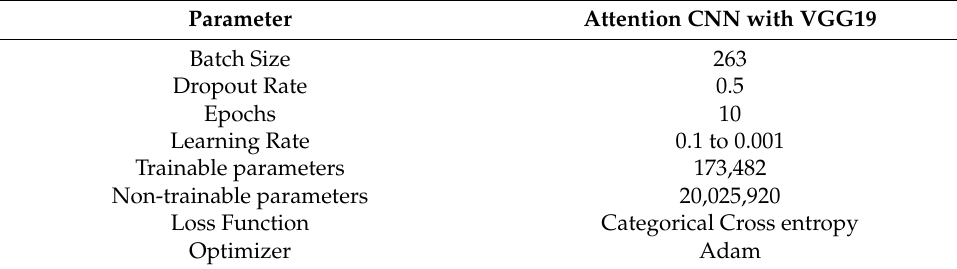
Table 1. Hyper parameters and other characteristics of proposed